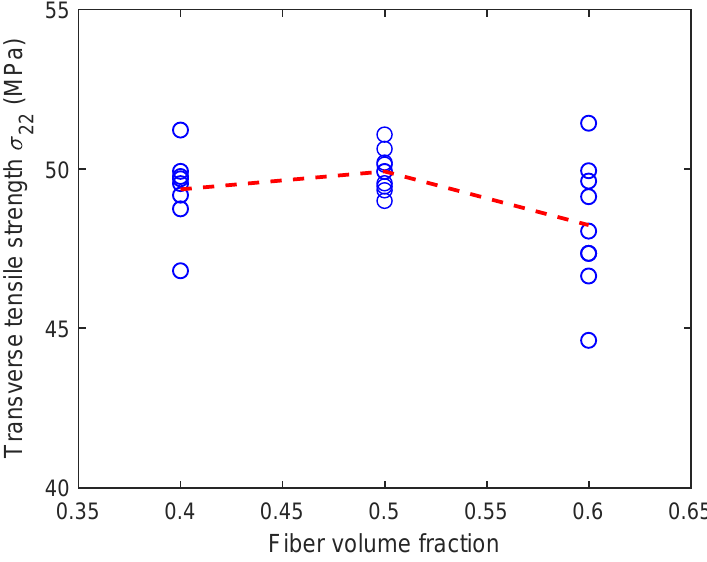
Figure 13. Effect of fiber volume fraction on the transverse tensile strength for six-fiber unit cells. (D’Mello and Waas